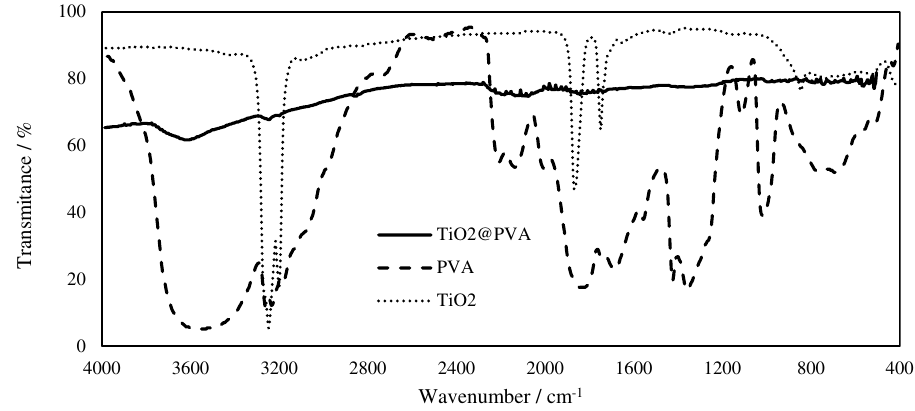
Figure 4. The FT-IR spectrum of nanocomposite TiO2@PVA (solid line), PVA (dashed line), and TiO2 (pointed line).